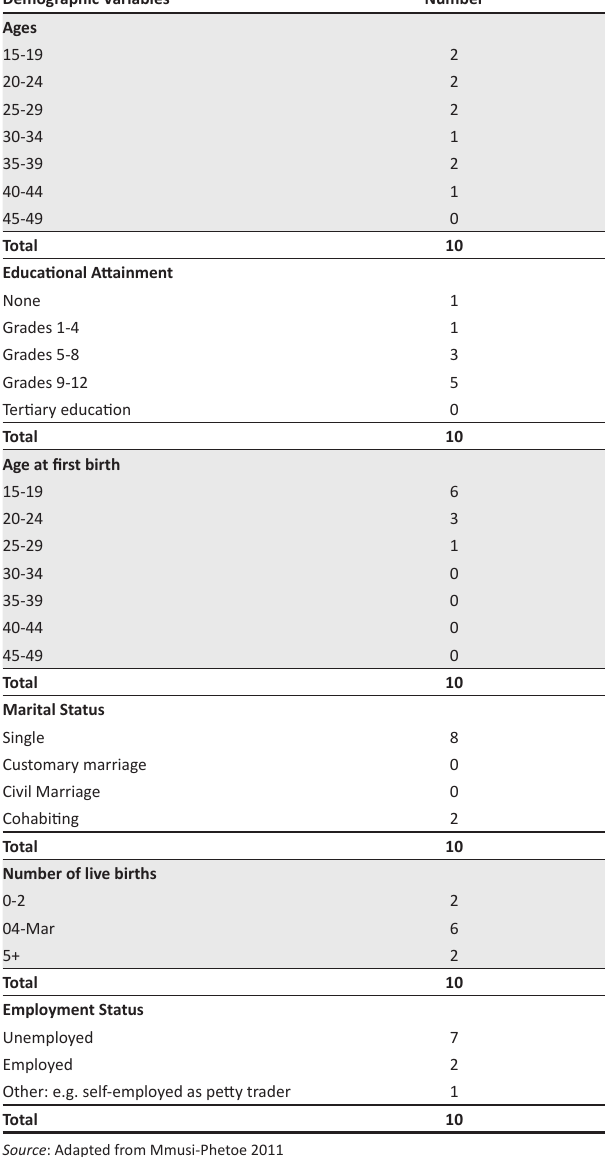
TABLE 2: Demographic characteristics of the